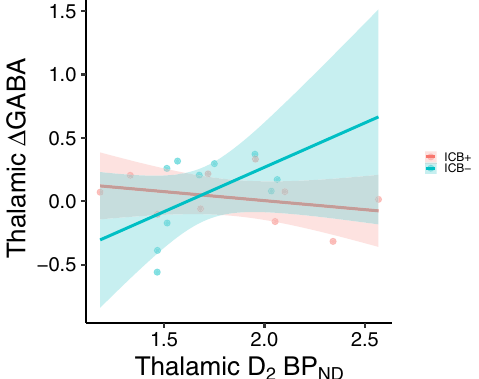
Fig. 4 Association between GABAergic response to dopamine agonist therapy and thalamic dopamine receptor availability. Scatter plot showing the relationship between the thalamic GABAergic response to DAA medication ( Δ GABA) and thalamic [ 18 F]fallypride BP ND in ICB + and ICB − patients, adjusting for age. Dark center lines indicate fi tted lines, while lighter colored bands denote con fi dence bands. This relationship appears to differ between ICB + and ICB − patients (GLM: Thalamic Δ GABA ~